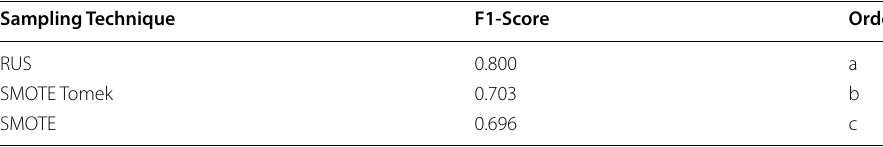
Table 14 Tukey’s HSD results for F1 score: sampling factor